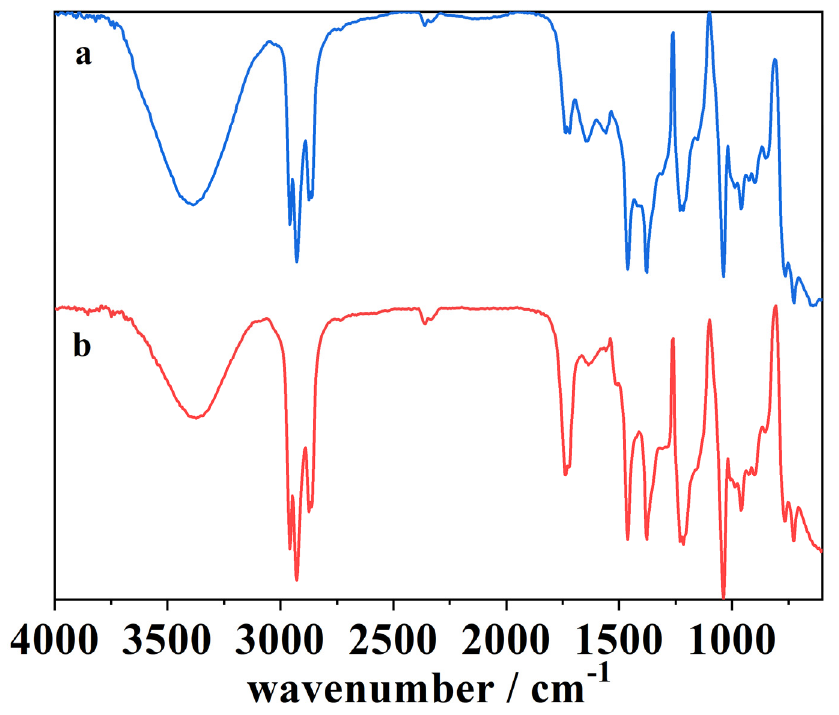
Figure 11. The ATR-FTIR spectra of ( a ) the blank cork bio-oil alkaline emulsion, not subjected to electrolysis, and ( b ) the cork bio-oil alkaline emulsion after Electrolysis III, a bulk electrolysis in a single-compartment cell.